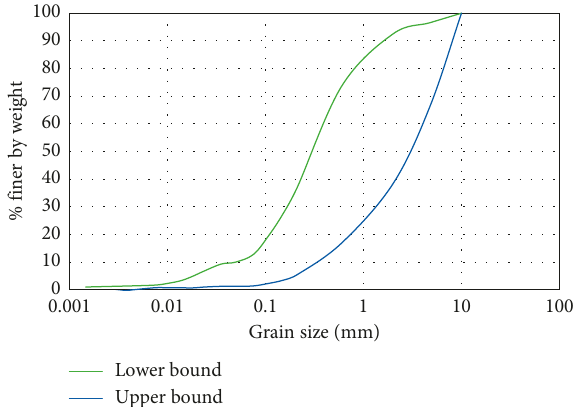
Figure 4: Grain size distribution of upper and lower bounds, classified according to the